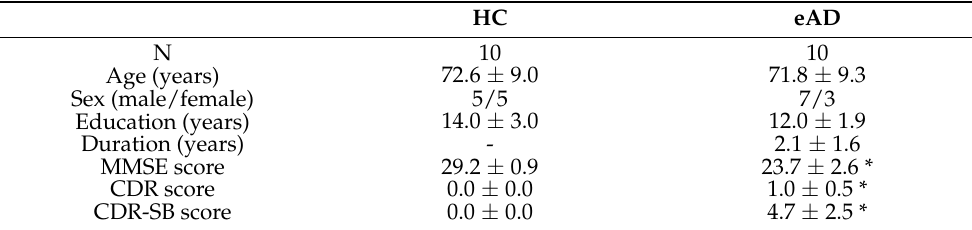
Table 1. Demographic characteristics of study participants (mean ±